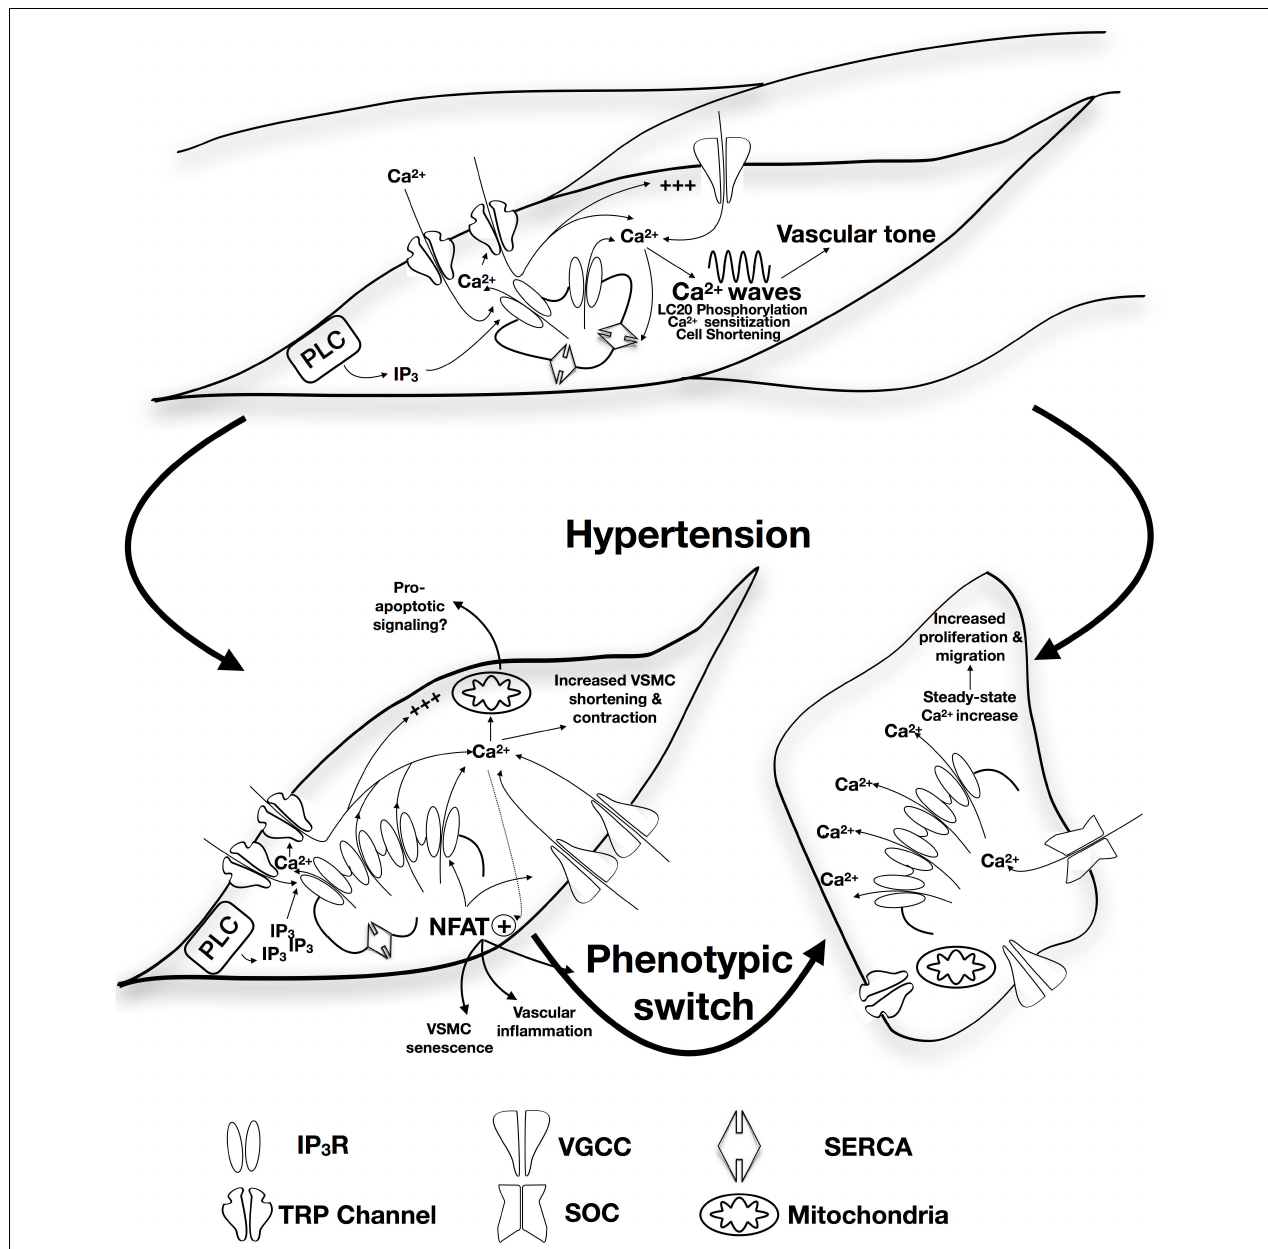
FIGURE 1 | Proposed role of alteration in IP 3 R expression/function in the development of hypertension. Apart from contribution to vascular tone and VSM contractility via SR-Ca 2 + release, calcium wave production, and induction of calcium sensitization, IP3R forms a mechanosensing complex with TRP channels that is proposed to initiate contraction in response to increased intraluminal pressure. Physiological patterns of IP 3 R-mediated Ca 2 + release are affected by the expression of other SR membrane proteins including SERCA. Under circumstances of sustained increased blood pressure, IP 3 R expression increases together with increased sensitivity to IP 3 and increased coupling with the TRP mechanosensing machinery resulting in increased intracellular Ca 2 + release and increased VSM contraction. Interplay with NFAT-mediated signaling pathways might contribute pressure-induced changes in VSMC phenotype, vascular inflammation, and VSMC senescence. Increased VSMC proliferation and migration were reported to involve increased IP 3 R-mediated Ca 2 + release with subsequent intracellular store depletion and increased store-operated Ca 2 + entry. IP 3 R-mediated Ca 2 + release can potentially relay apoptotic signaling to the mitochondria contributing to vascular